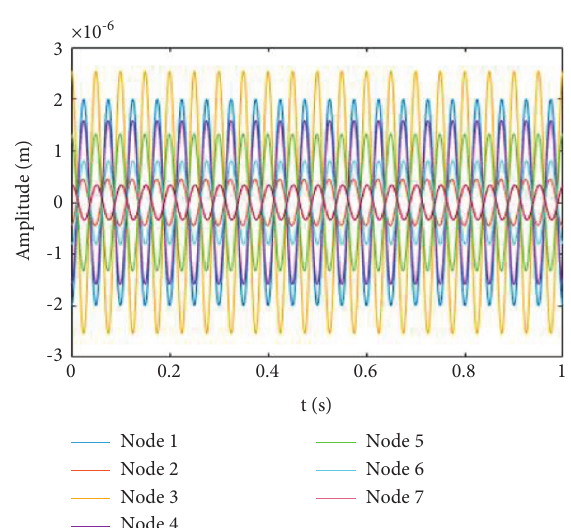
Figure 11: Time-domain imbalance response of each node of a single